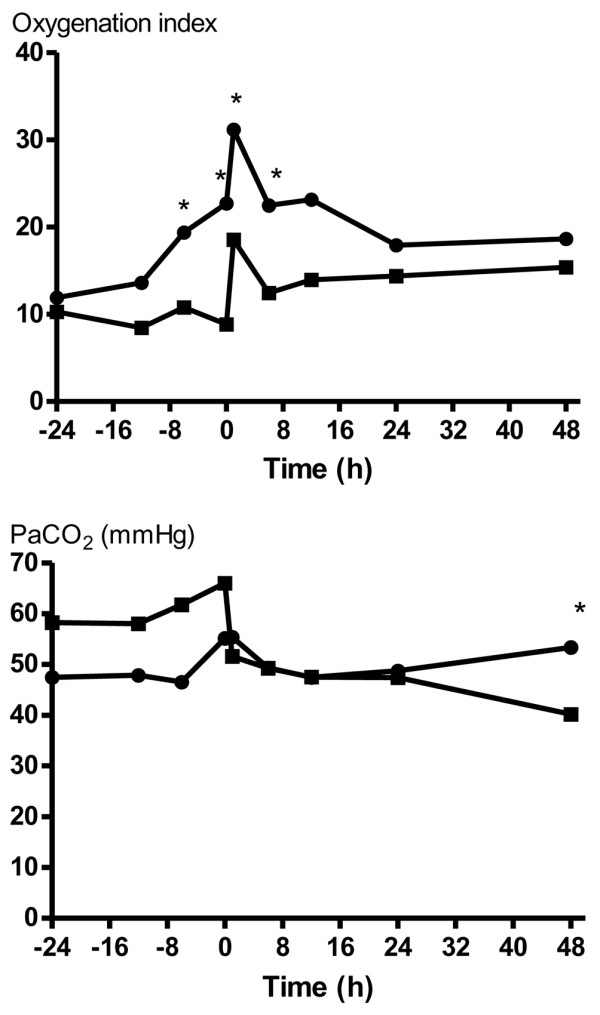
The oxygenation index (OI) before and during high-frequency oscillatory ventilation (HFOV) in patients with diffuse alveolar disease (DAD) (●) and in patients with small airway disease (SAD) (■). The OI became significantly higher 6 hours prior to HFOV therapy and remained higher. The observed rise in the OI in the first hour after transition to HFOV in both groups is due to the applied higher CDP when compared with the mean airway pressure during conventional mechanical ventilation. The SAD patients had a higher, but not significant, PaCO2 before transition to HFOV than the DAD patients. PaCO2 returned to normal values after transition to HFOV. * P < 0.05.